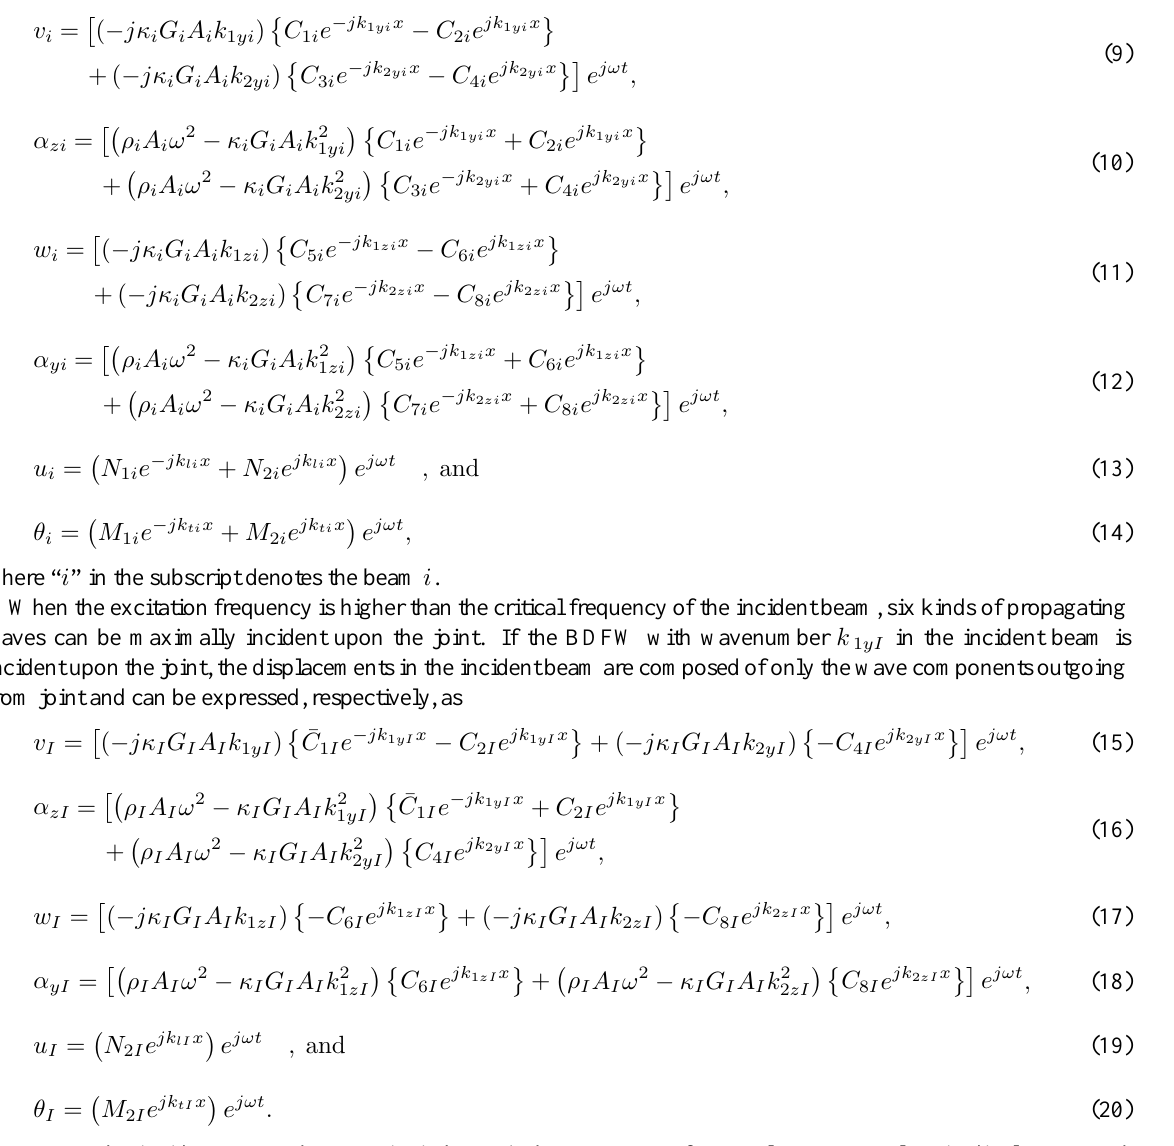
Fig. 3. Two semi-infinite Timoshenko beams joined at an arbitrary